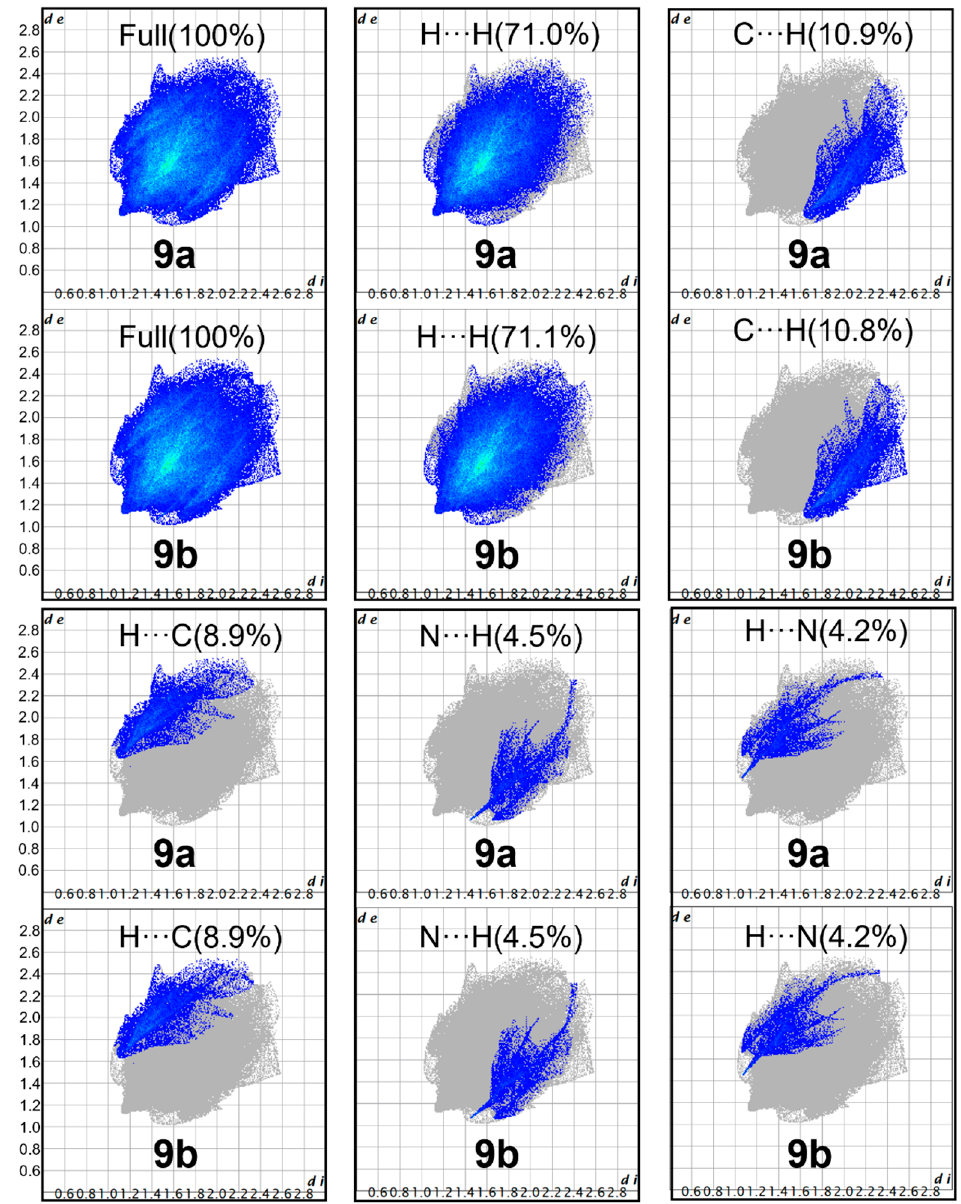
Figure 11. The 2D-fingerprint plots for all and outlined in H ··· H, C ··· H, H ··· C, N ··· H, and H ··· N intermolecular contacts through HSs in crystalline molecules 9a and 9b . In A ··· B contacts, atom A is inside HS, while atom B is outside HS.